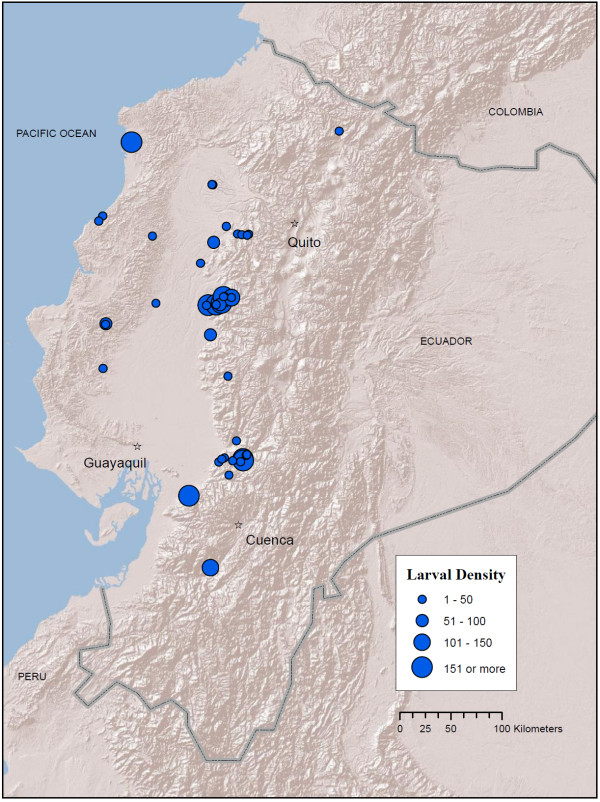
Map of An. pseudopunctipennis localities in Ecuador (blue circles) from larval collections conducted between 2008 - 2010. Circle size (legend) indicates mean number of larvae per dip in a 30-dip sample. Map prepared in ArcGIS v.9.3 with ESRI World Terrain base [59].